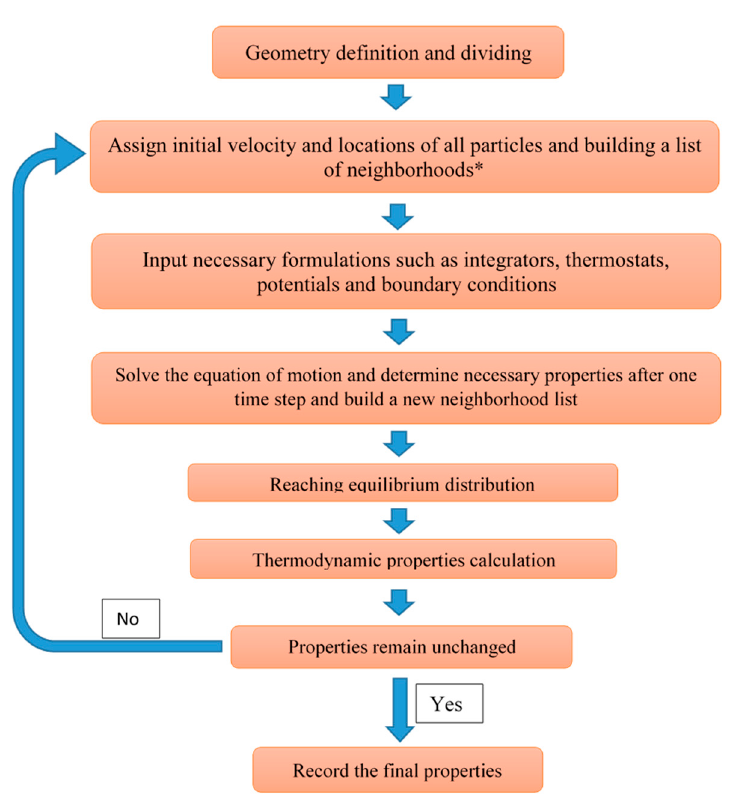
Figure 8. Deterministic particle dynamics schematic algorithm (*: there are some pre-defined functions to initialize the domain if using the software packages. One can refer to the associated websites and add the functions/libraries beforehand).